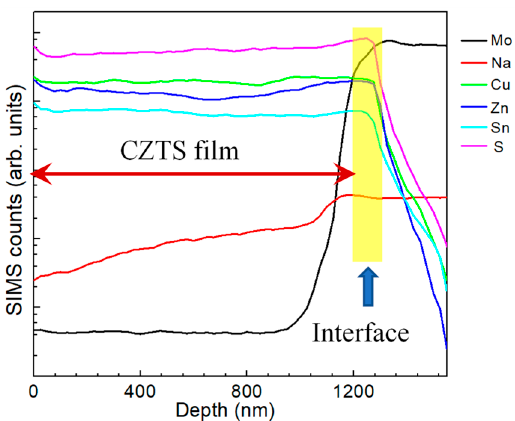
Figure 2. Depth profiles of elements in a CZTS film by secondary ion mass spectroscopy (SIMS) characterization for Mo, Na, Cu, Zn, Sn and S.